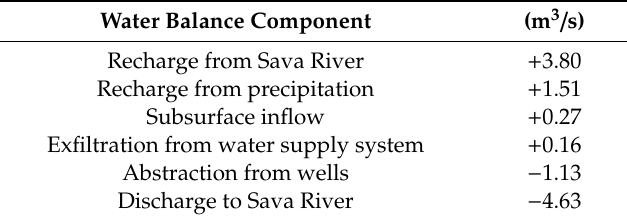
Figure 2. The calibrated transmissivity of the aquifer. Table 1. Water balance components (modeling period